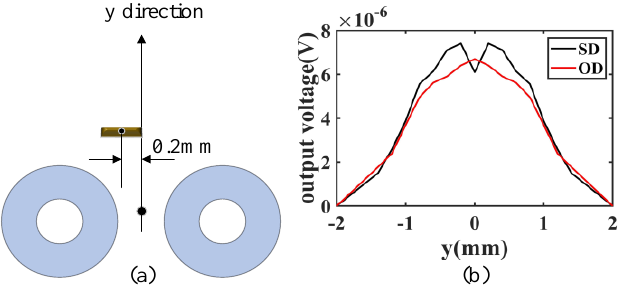
Figure 5. ( a ) The positions of the horizontal defect to the two coils in the simulation model, ( b ) the